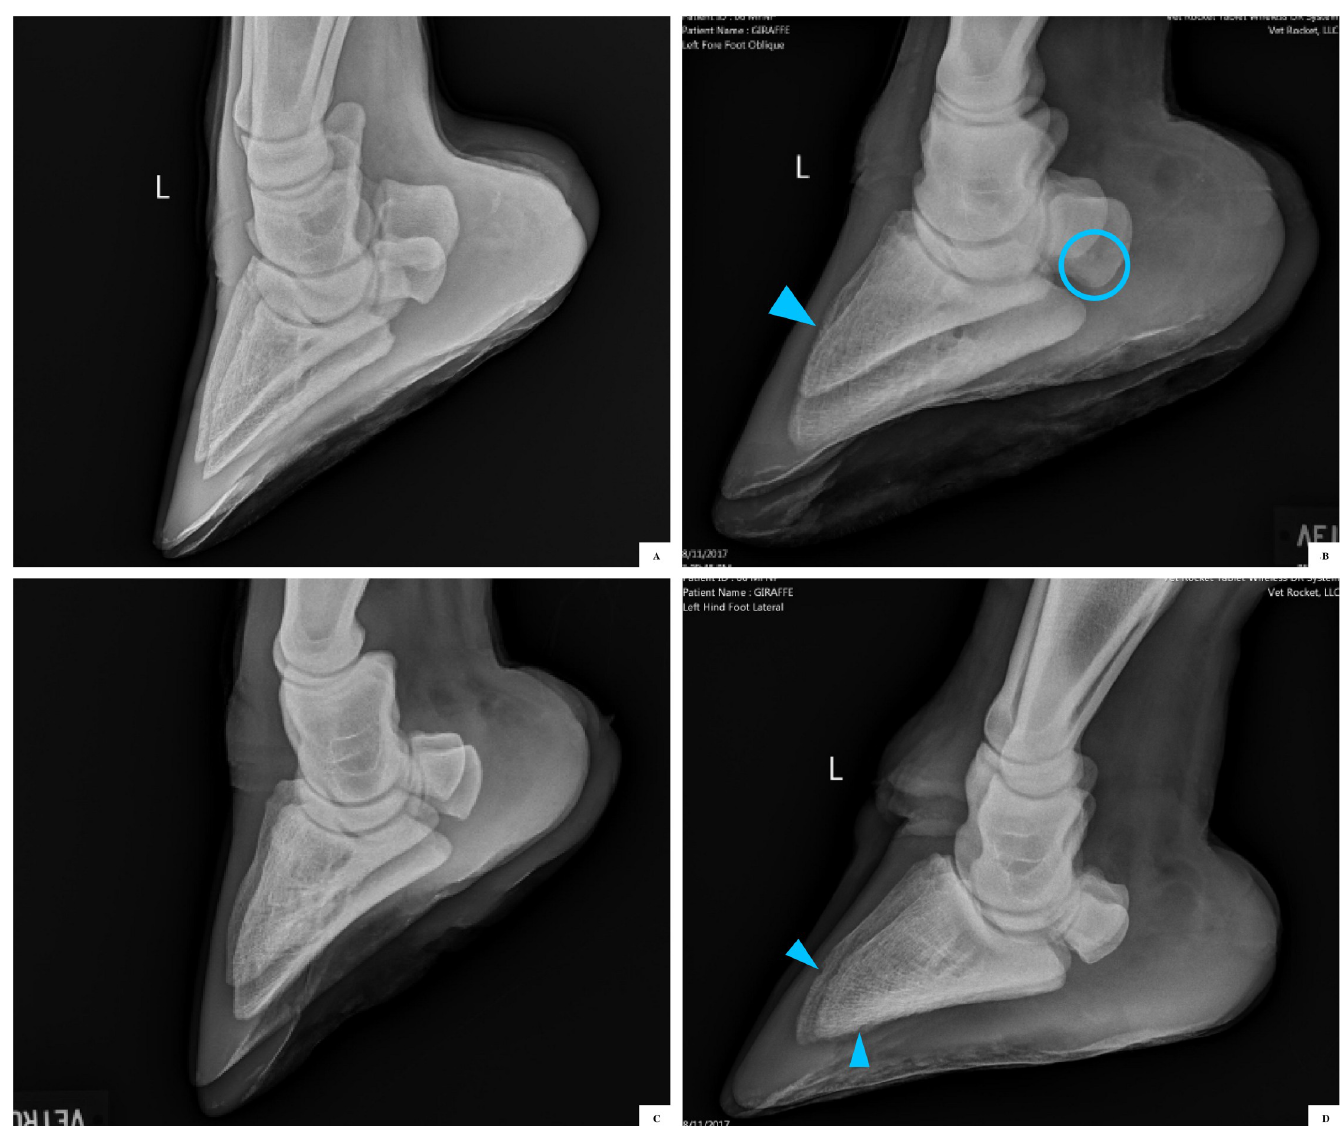
Fig 2. Foot radiographs from free-ranging young adult giraffe. Projections were collected with giraffe in lateral recumbency, using either a medial or lateral oblique projection (dorsomedial-palmarolateral or dorsolateral-palmaromedial oblique). (A) Normal front foot with no pedal osteitis or sesamoid cysts. (B) Abnormal front foot with mild (level 1) pedal osteitis on the dorsal surface (blue arrow) and sesamoid cysts (in circle). (C) Normal hind foot with no pedal osteitis or sesamoid cysts. (D) Abnormal hind foot with mild (level 1) pedal osteitis involving both the dorsal and plantar surfaces (blue arrow). In both the front and hind feet the sole plane runs parallel to P3 bone. Compared to the front foot, the hind foot has a more rounded toe tip of the distal phalangeal bone.